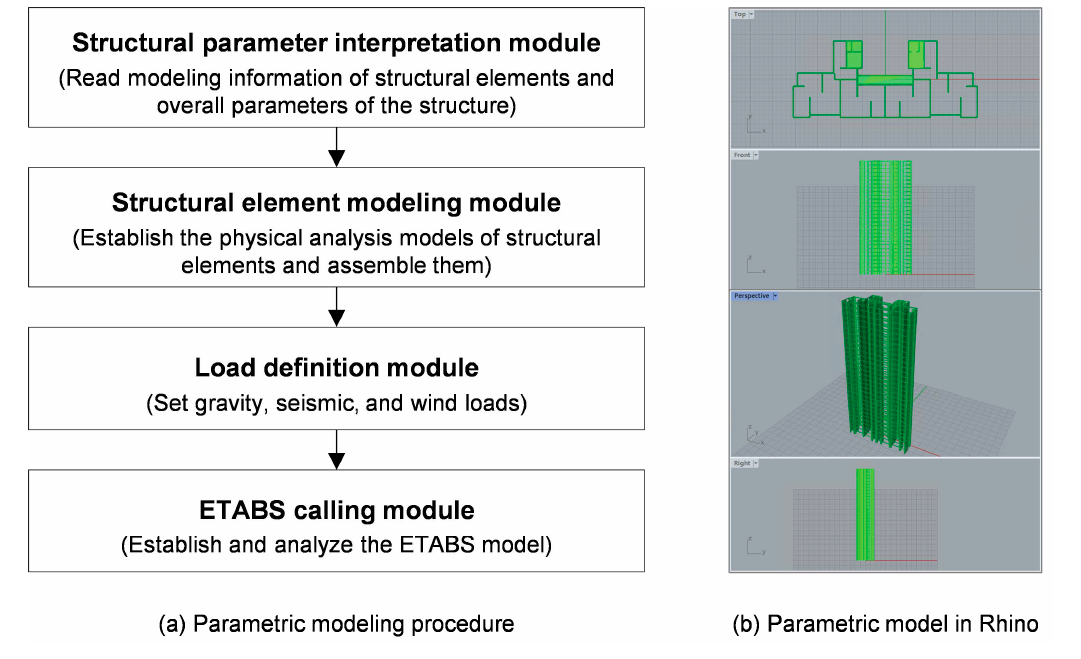
Figure 8. Parametric modeling procedure based on Swallow (ESD).